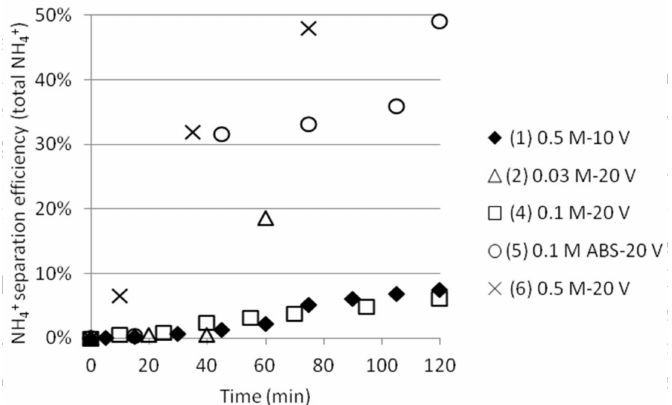
Figure 5. NH 4+ separation efficiency as function of